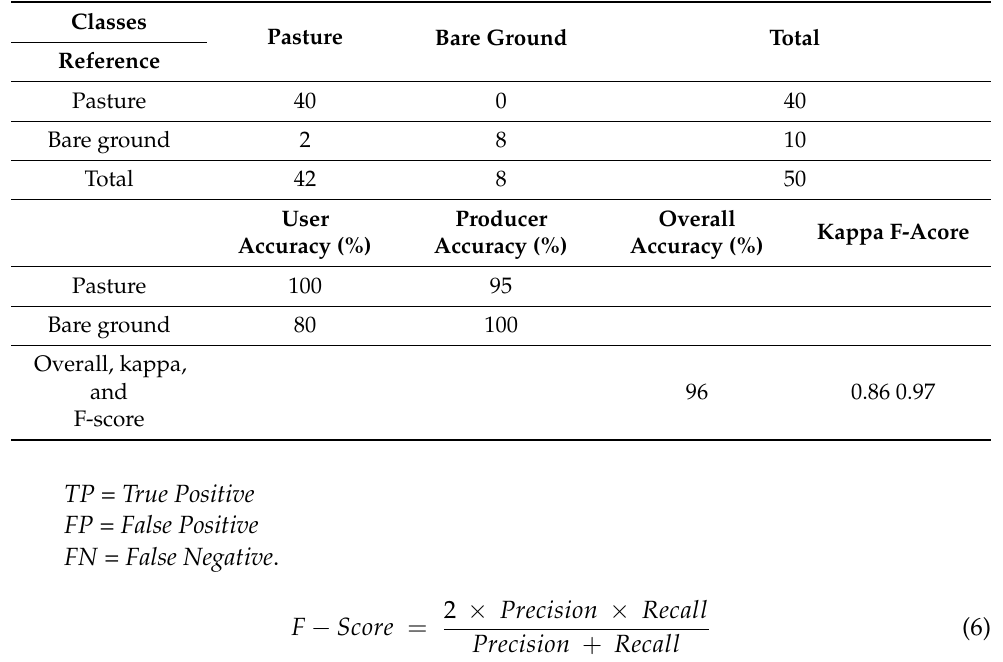
Table 1. Error matrix table of post-flooding grazing land cover